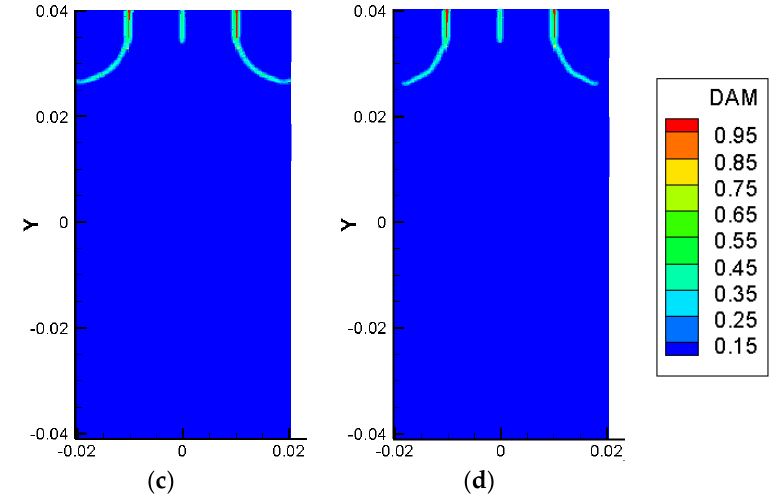
Figure 12. Snapshots of the crack maps in different FGM specimens with the elastic modulus as an exponential function at 100 µs: ( a ) E 2 / E 1 = 0.5; ( b ) E 2 / E 1 = 2.5; ( c ) E 2 / E 1 = 5; ( d ) E 2 / E 1 = 10.